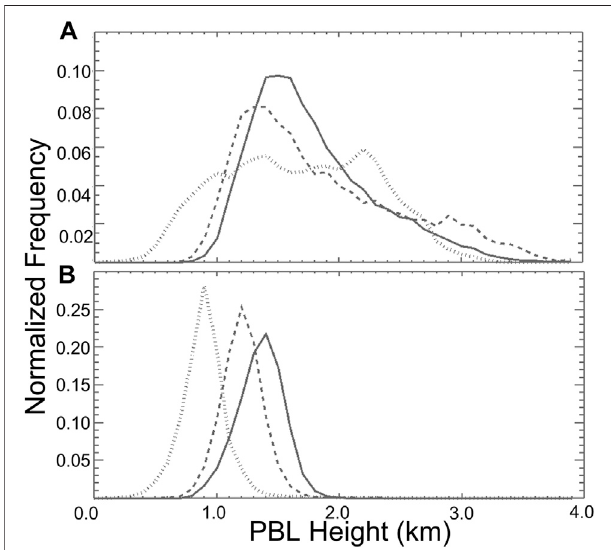
FIGURE 12 | Normalized probability distributions of PBL height for land (A) and ocean (B) for all 2016 night CATS granules. The solid, dashed, and hatched lines correspond to results from the threshold and CNN algorithms and MERRA-2 reanalysis (14:00 Local time) between 51S and 51N,